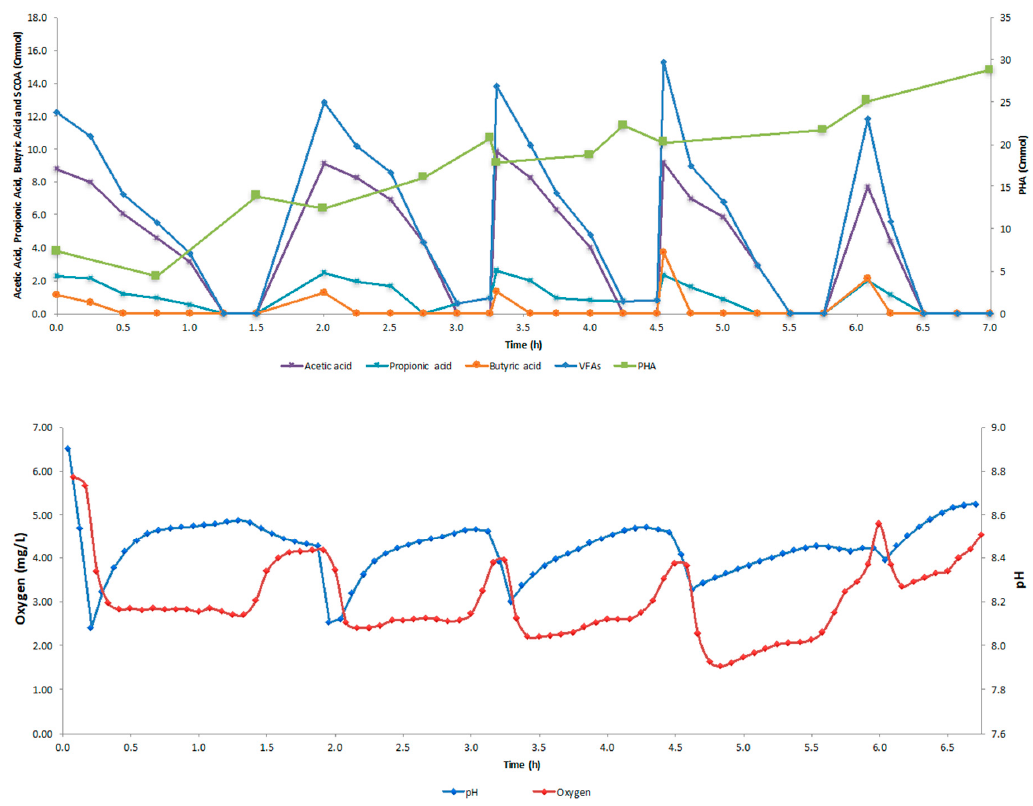
Figure 4. Evolution of pH (red line), DO (dark blue line), PHA (green line), Acetic Acid (purple line), Propionic Acid (light blue line), Butyric Acid (orange line) and SCOAs (blue line) concentrations in